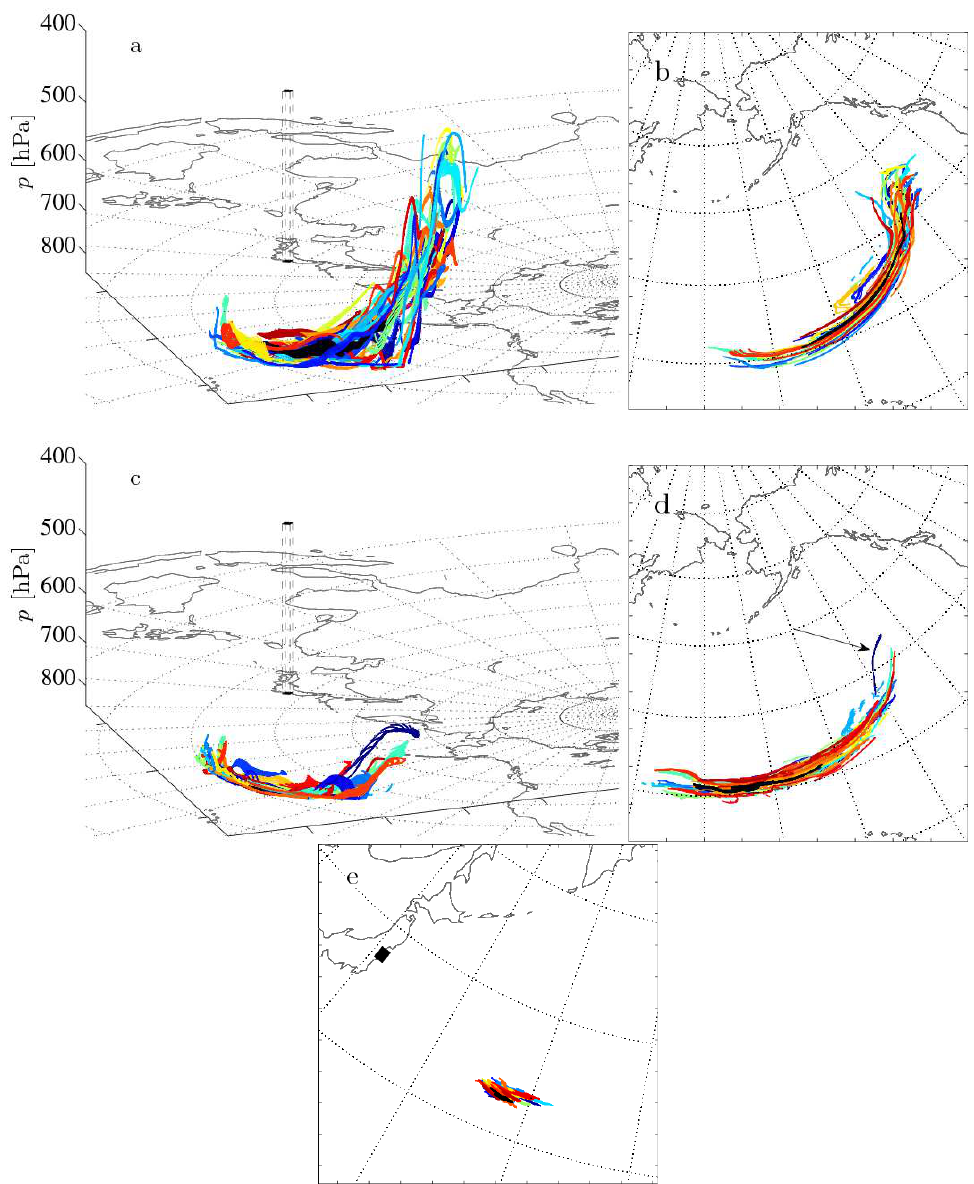
Fig. 1. The distribution of particles of r = 1µm (a, b) and of r = 4µm (c, d) in 3-D (a, c) and in a planar projection (b, d) , respectively, after 2.5 days. Panel (e) shows the r = 10µm particles deposited on the 850hPa pressure level. Colors (blue to red) indicate the ensemble members; black is the deterministic forecast (overlaid on top of the others in panels b, d, e ). Black rectangles mark the initial condition above Fukushima and its surface-projected location. For the arrow in panel d, see text. For the ensemble members only every 20th particle is plotted.